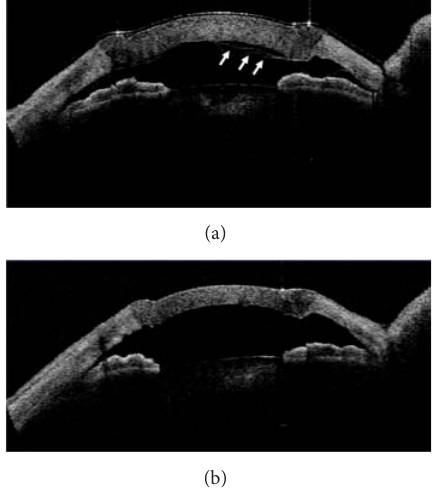
Figure 5: AS-OCT images demonstrating detachment of the Descemet’s membrane (DM; white arrow) after DALK (a) and reattachment of the DM after intracameral air injection